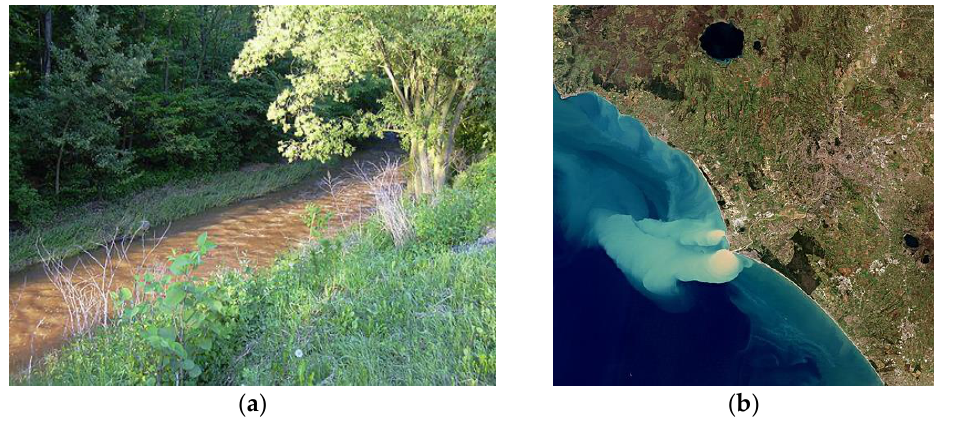
Figure 3. ( a ) Sediment transport; ( b ) River discharging sediment